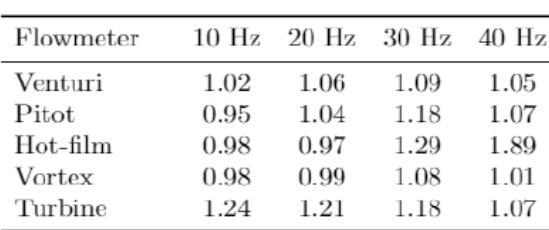
Table 1. Relative deviations of mean mass flow from reference value of 80 g/s of various types of flow measurement devices for given flow pulsation frequencies